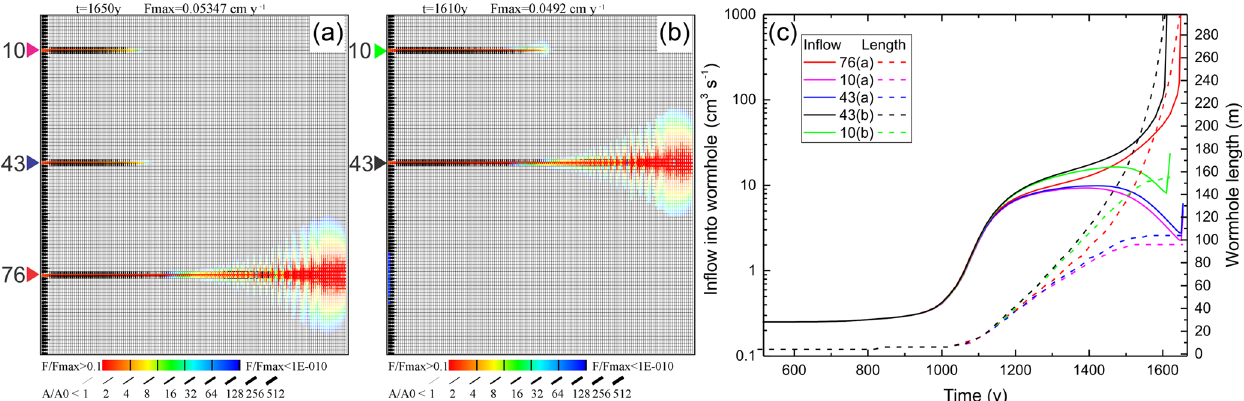
Figure 7. Breakthrough situation in a network with (a) three seeds at positions 10, 43, and 76 and (b) two seeds at positions 10 and 43. (c) Evolution of input flow rates and wormhole lengths for seeded wormholes in (a) and (b) . Note that the winning wormholes, black curve (43 b) and red curve (76 a), show a very similar